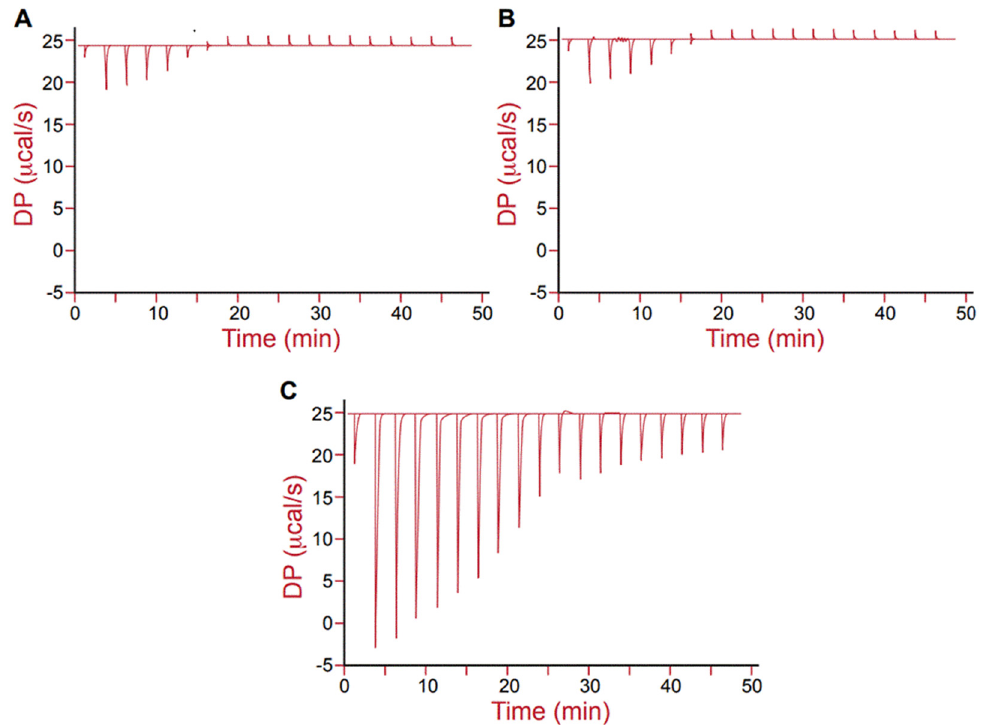
Figure 3. Heat flow versus time profiles resulting from injection of 2 µL aliquots of DDAC (20 mM) into a 280 µL titration cell containing different aqueous solutions, from left to right: ( A ) 0.1 M carbonate/bicarbonate buffer; ( B ) 2.83 mM dextran and ( C ) 2.83 mM SLS.